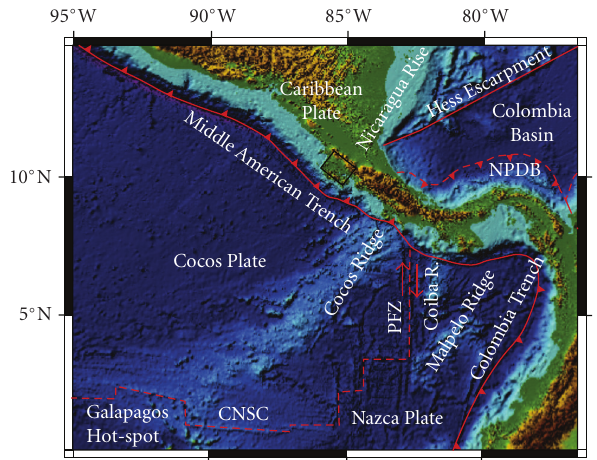
Figure 1: Tectonic setting of the Costa Rican subduction zone. Major plate boundaries and tectonic features are marked by red lines. Locations of the 3D density model is indicated by a black polygon. NPDB: North Panam´a Deformed Belt; PFZ: Panam´a Fracture Zone; CNSC: Cocos-Nazca Spreading